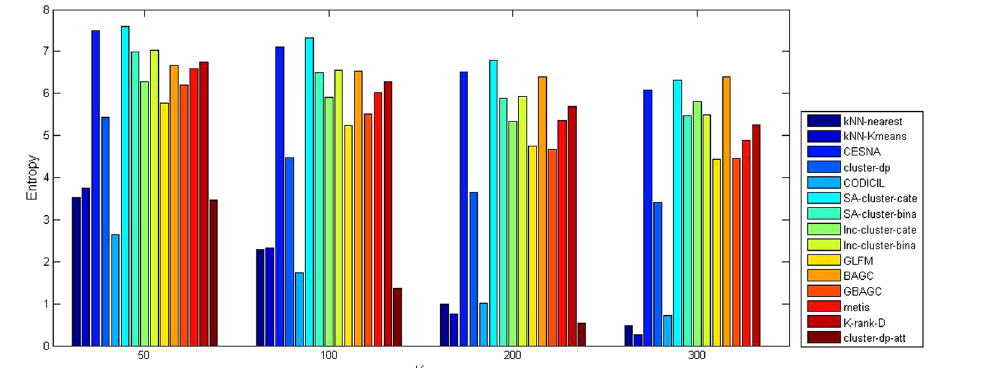
Figure 4. Entropy of the compared algorithms on DBLP10k.